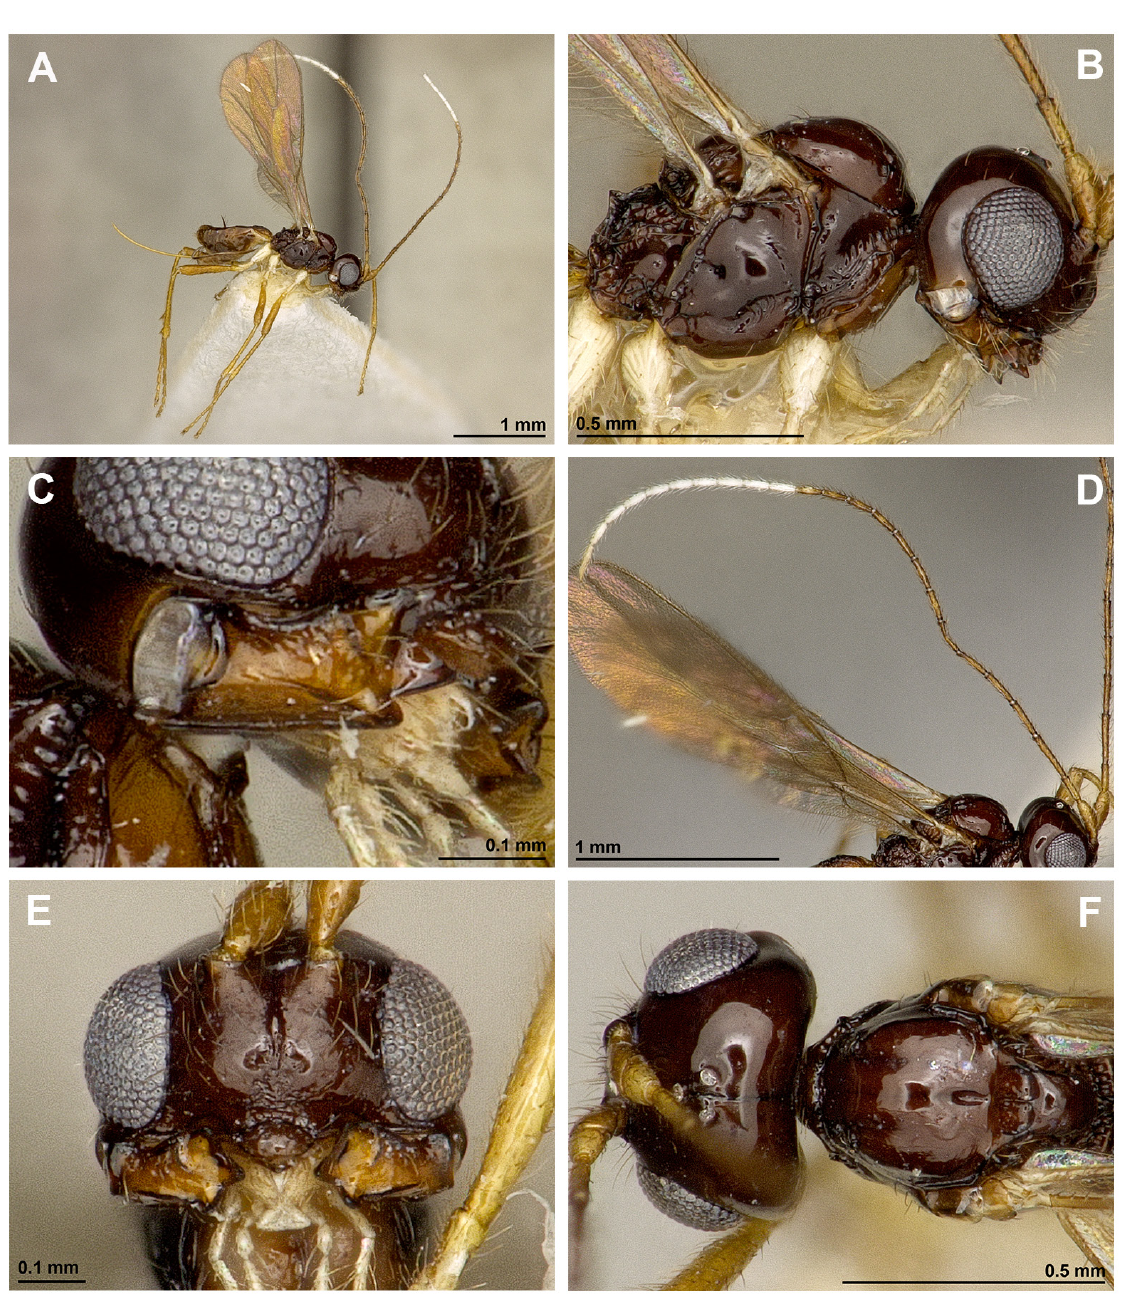
Fig. 11. Asobara cracentis van Achterberg, sp. nov., ♀, holotype (RMNH). A . Habitus, lateral view. B . Head and mesosoma, lateral view. C . Mandible. D . Antenna. E . Head, front view. F . Head and mesoscutum, dorsal